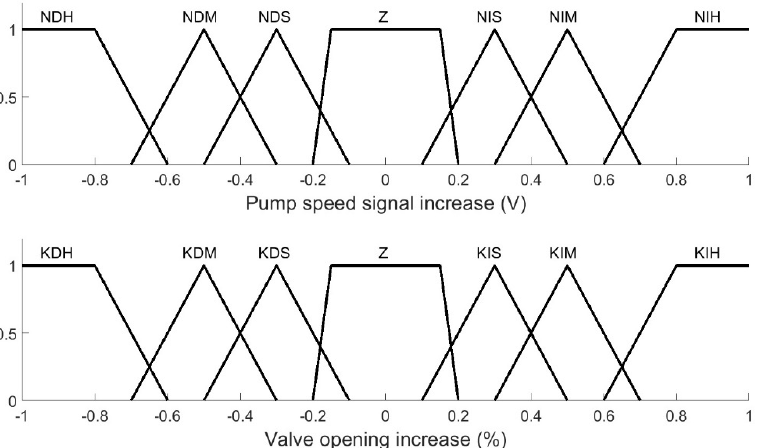
Figure 10. Linguistic values assigned to the controller outputs.